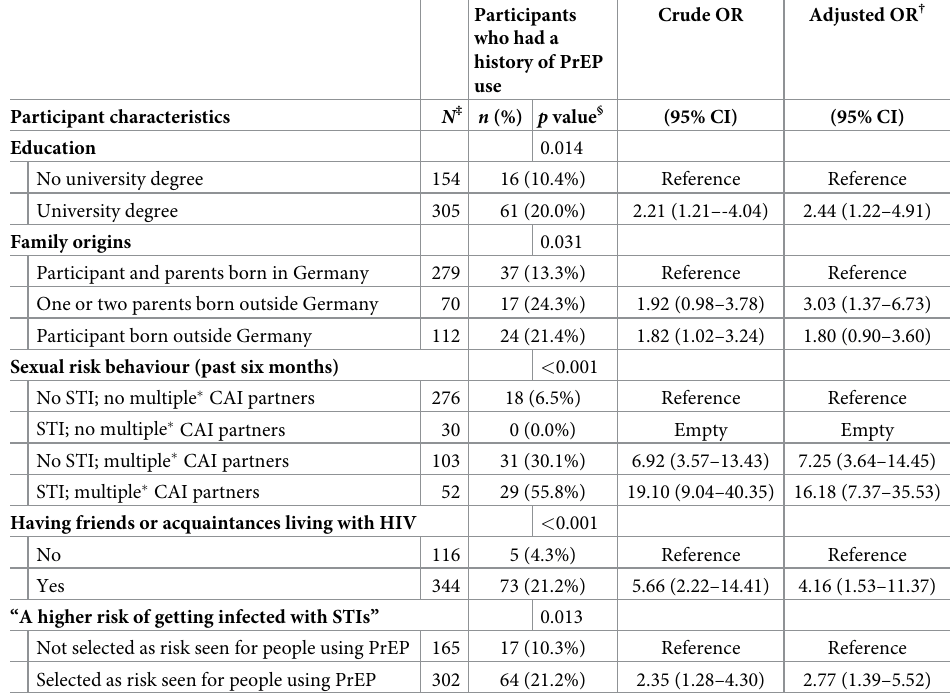
Participants Crude OR Adjusted OR † who had a history of PrEP use